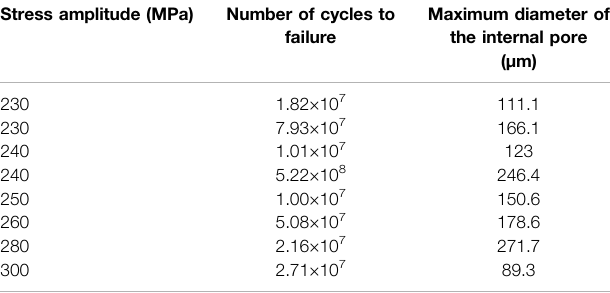
TABLE 1 | Maximum diameter of the internal pore for the LBW-made weldments. Stress amplitude (MPa) Number of cycles to